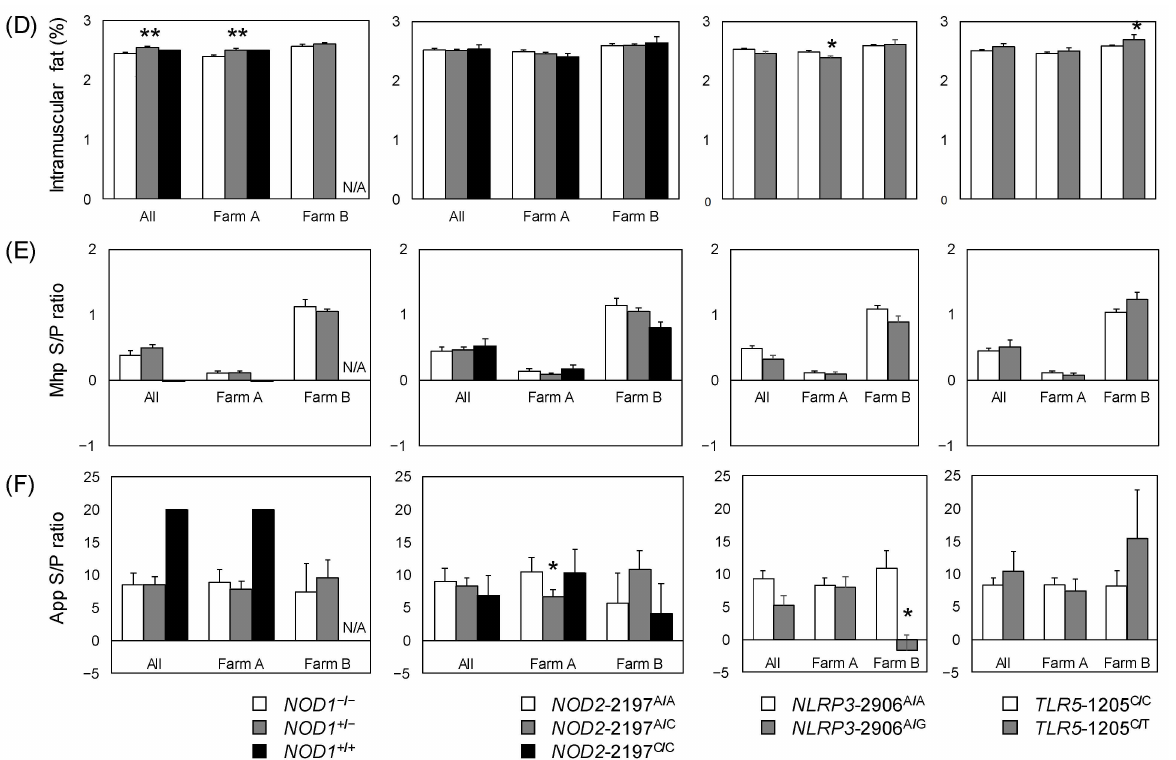
Figure 1. Trait values by PRR genotype for all of the pigs studied. ( A ) log-transformed Goodwin lung lesion score; ( B ) pleuritis (SPES score); ( C ) backfat thickness adjusted by carcass weight; ( D ) intra- muscular fat ratio; and antibody titers of ( E ) Mhp and ( F ) App. Error bars: standard error. Significant differences in the estimates (Tables 5, S2 and S3) are indicated by asterisks (** p < 0.01, * p < 0.05). N/A, not applicable, because no NOD1 +/+ individuals were observed on farm